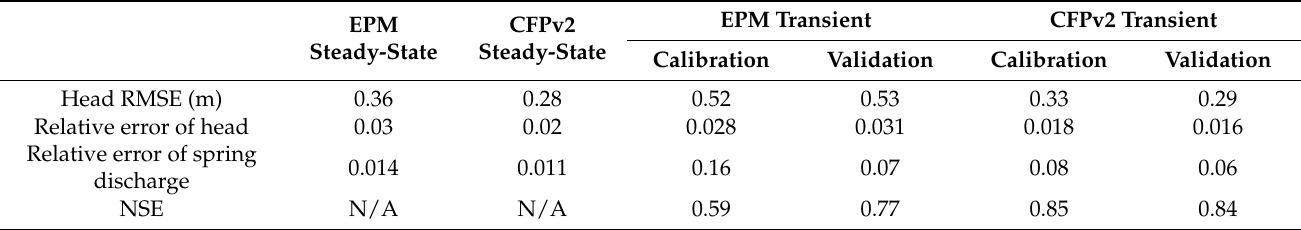
Figure 6. ( a ) Observed long-term average water levels versus the simulated hydraulic heads from the steady-state CFPv2 model; ( b ) observed water levels versus the simulated hydraulic heads from the transient CFPv2 model. Table 2. Hydrologic calibration statistics for the EPM and CFPv2